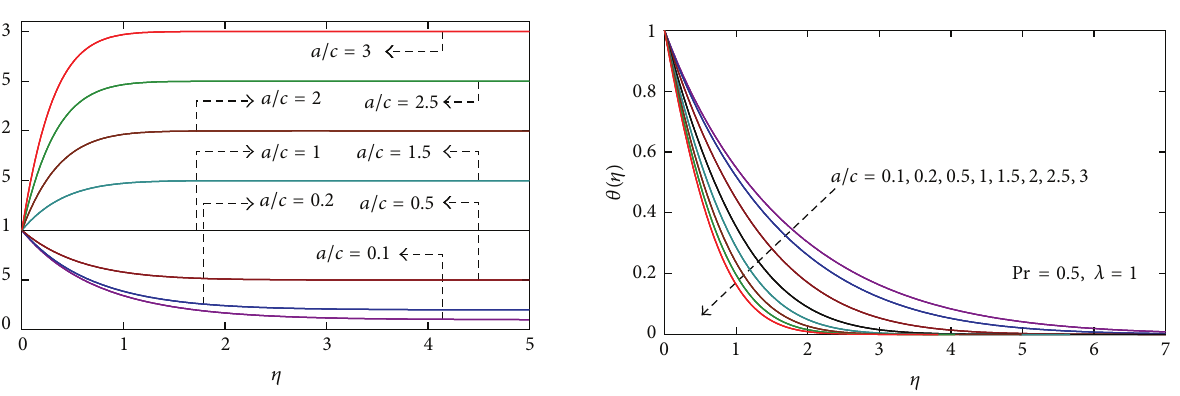
Figure 4: Temperature profiles 𝜃(𝜂) for various values of 𝑎/𝑐 .